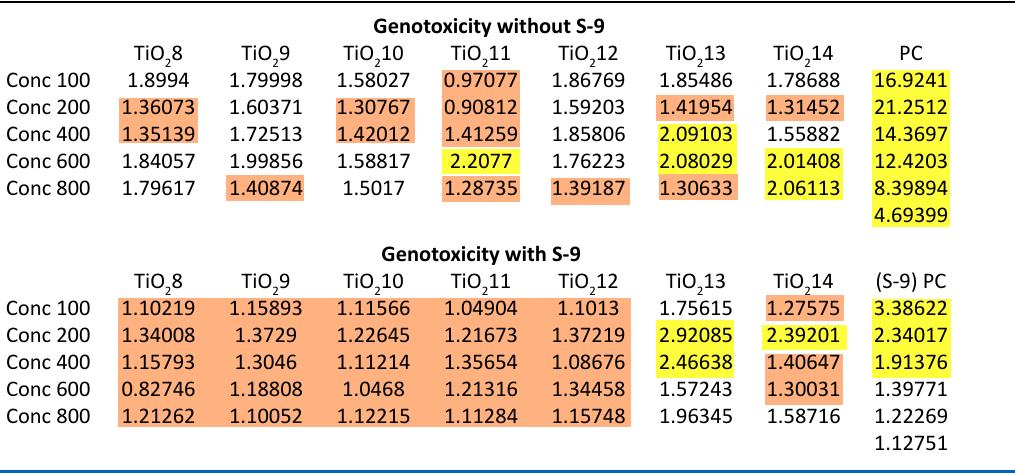
Table 3. The Results of SOSIF Genotoxicity / Mutagenicity (orange colour is Non-Genotoxic/Mutagenic, yellow colour represents Genotoxicity/Mutagenicity, and white colour indicates inconclusive